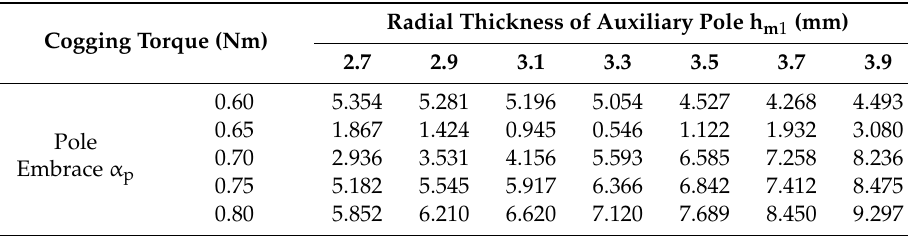
Table 2. Cogging torque of different auxiliary pole sizes.